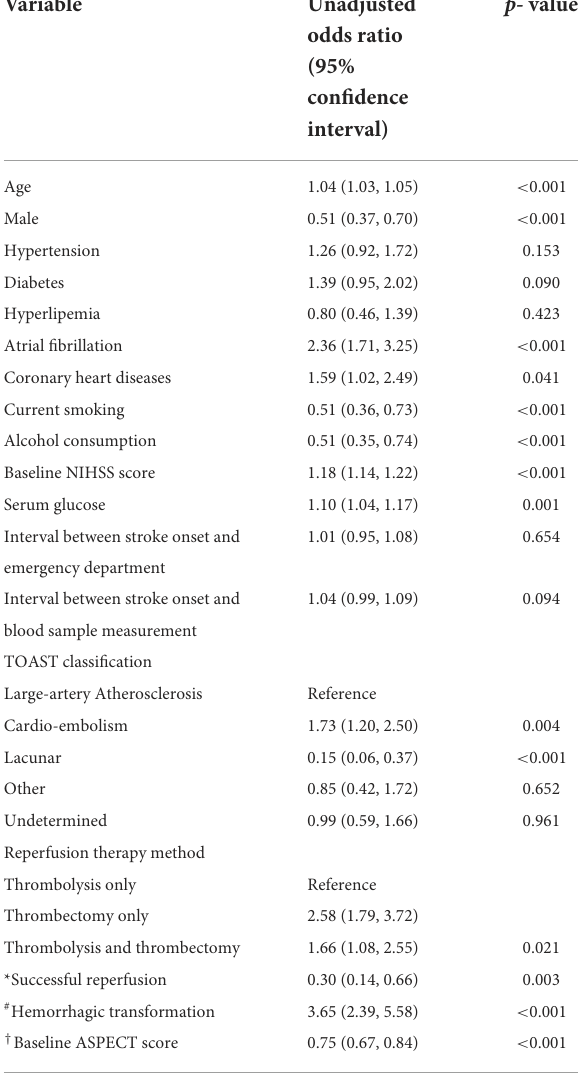
TABLE 2 Univariable logistic regression analysis of variables associated with poor 3-month outcome. Variable